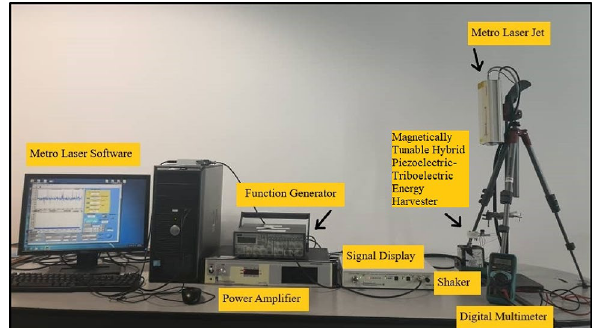
Figure 1. Experimental setup for the output voltage measurement of